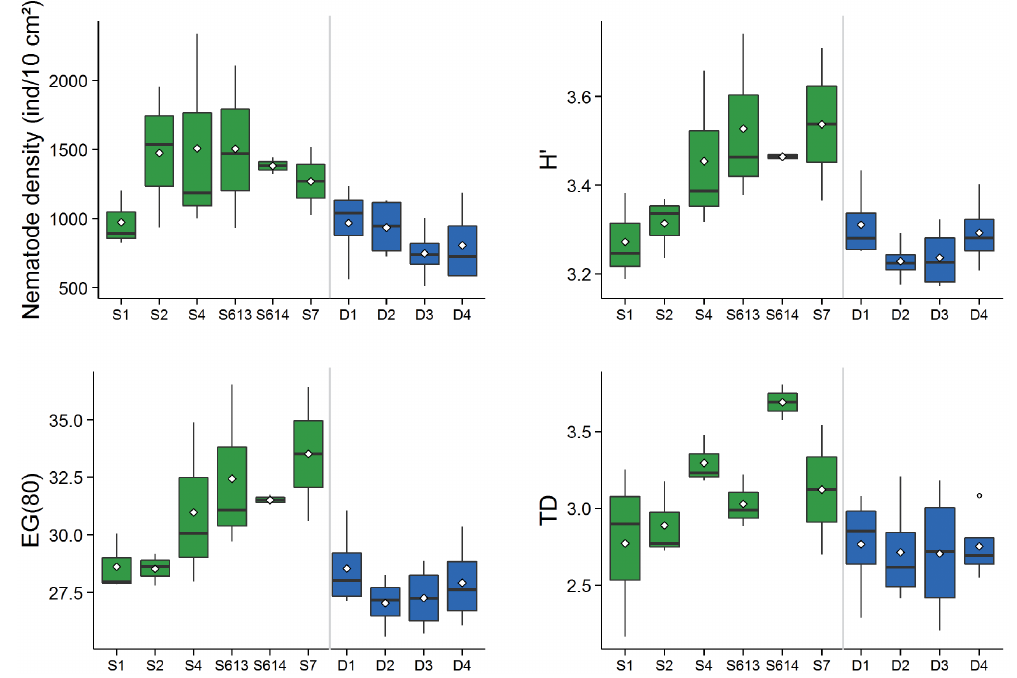
Figure 4. Nematode Shannon–Wiener (H (cid:48) ) diversity, nematode density (individuals10cm − 2 ), expected number of genera (EG(80)), and trophic diversity (TD) per station. Green box plots represent shallow stations and blue box plots represent deep stations. Black lines represent the median, empty circles represent the mean, lower box indicates the first quartile, and upper box the third quartile. Upper line shows the maximum value and lower line the minimum